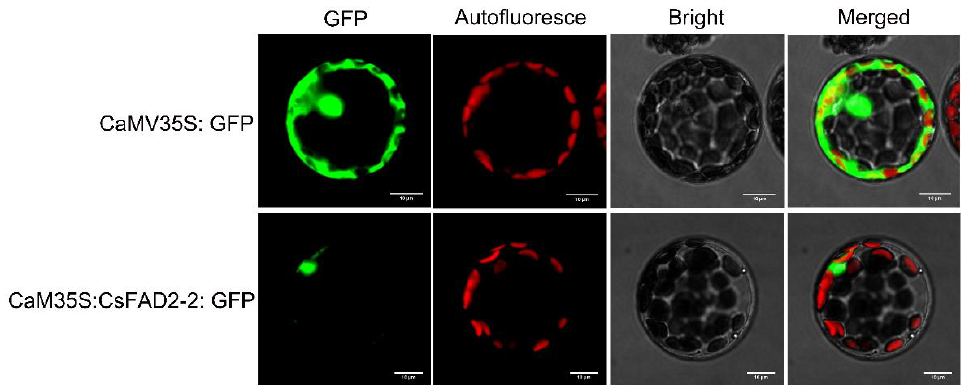
Figure 6. Subcellular localization of CsFAD2-2. Subcellular localization of CsFAD2-2 in Arabidopsis protoplasts. CsFAD2-2 was fused with CaMV35S: GFP to obtain the GFP–CsFAD2-2 fusion protein. The upper row shows the fluorescent signal from transforming CaMV35S: GFP vector. The bottom row shows the fluorescent signal from transforming CaMV35S: CsFAD2-2–GFP vector. Scale bars, 2 µ m.